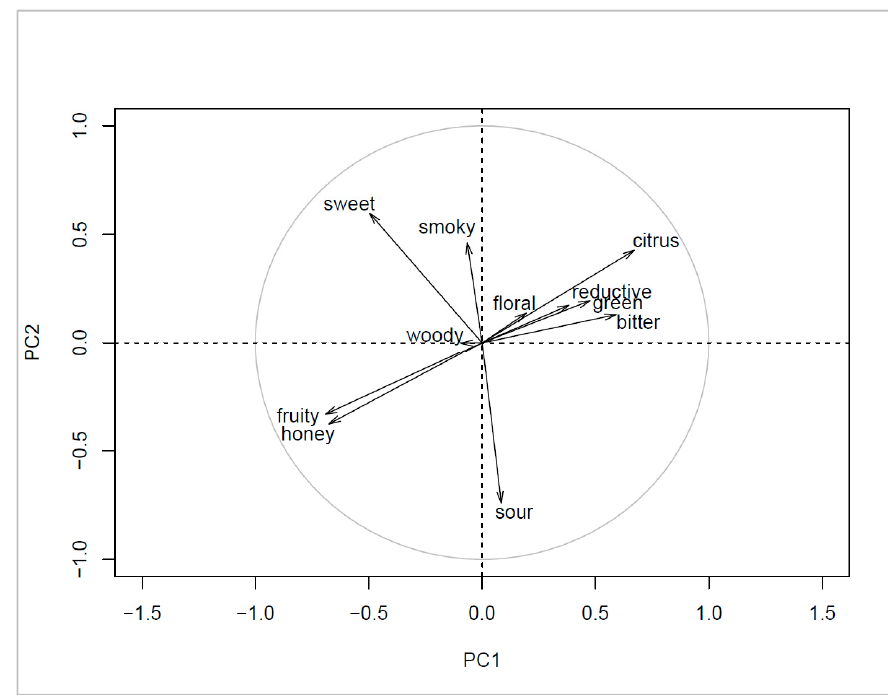
Figure 6. The results of the napping procedure. The wines are named after the yeast strain used for the fermentation, and the wines with the brighter ellipses were grouped together by the panelists.